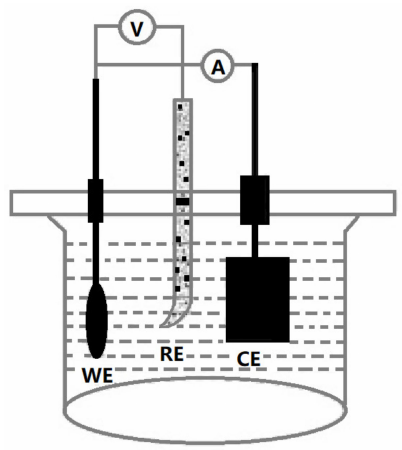
Figure 1. Three Electrode System Scheme of Experiment Apparatus.